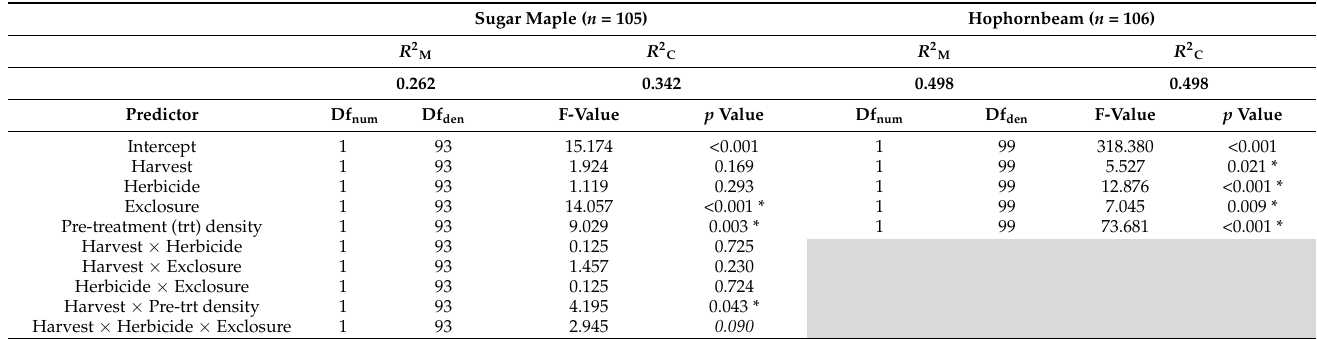
Table 4. Mixed model effects of harvest, herbicide, exclosure, and pre-treatment density on sugar maple and hophornbeam sapling (>45.7 cm tall, <15.2 cm dbh) density in 80.94 m 2 plots of managed northern hardwood forests in the Upper Peninsula of Michigan, USA. The site was included as a random effect. Models first included all treatment interactions and were then simplified if no interaction effect was detected (i.e., p > 0.10). Lower order interactions were retained if higher order interactions were statistically significant. * Asterisks indicate statistical significance ( p < 0.05), italicized values indicate marginal significance (0.05 < p < 0.10). R 2 M , marginal R 2 (fixed effects only); R 2 C , conditional R 2 (fixed and random effects); Df num , numerator degrees of freedom; Df den , denominator degrees of freedom.